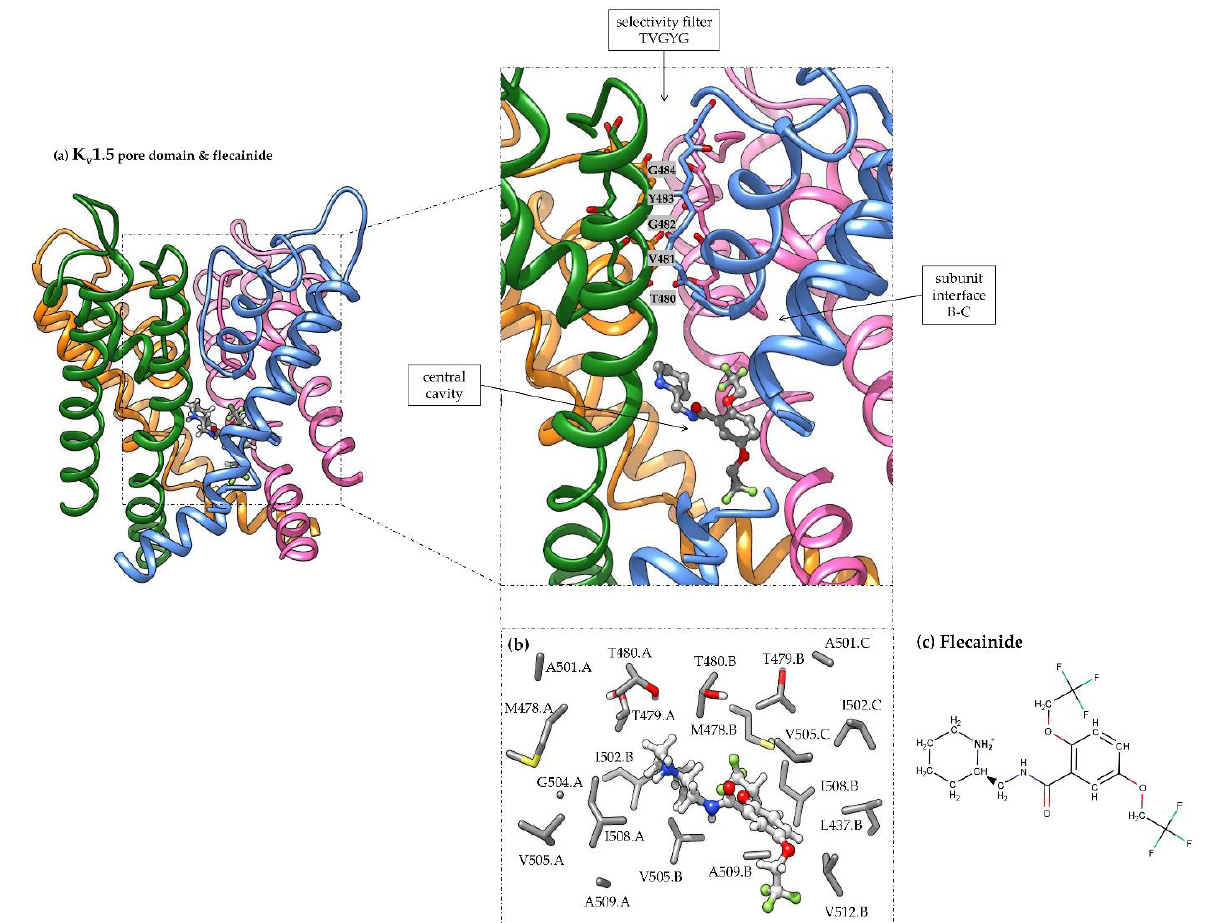
Figure 1. Representation of flecainide binding mode in K v 1.5 channel . ( a ) Ribbon representation of K v 1.5 pore domain; each subunit is shown in a different color: orange (subunit A), pink (subunit B), blue (subunit C), green (subunit D), and flecainide bound in the inner cavity is depicted in ball and sticks. Residues forming the selectivity filter are labeled and indicated in gray boxes. ( b ) Side- chain representation of residues in contact with flecainide (distance ≤ 5 Å ) having a frequency of interaction ≥ 70% along MD simulations. Residue names and numbers are indicated. The tertiary structure used corresponds to a frame from the holo MD trajectories. ( c ) Flecainide representation in 2D format. Flecainide and residues are colored per element with carbon atoms in dark gray, oxygen atoms in red, nitrogen atoms in blue, sulfur atoms in yellow, hydrogens in light gray and fluorine in green.